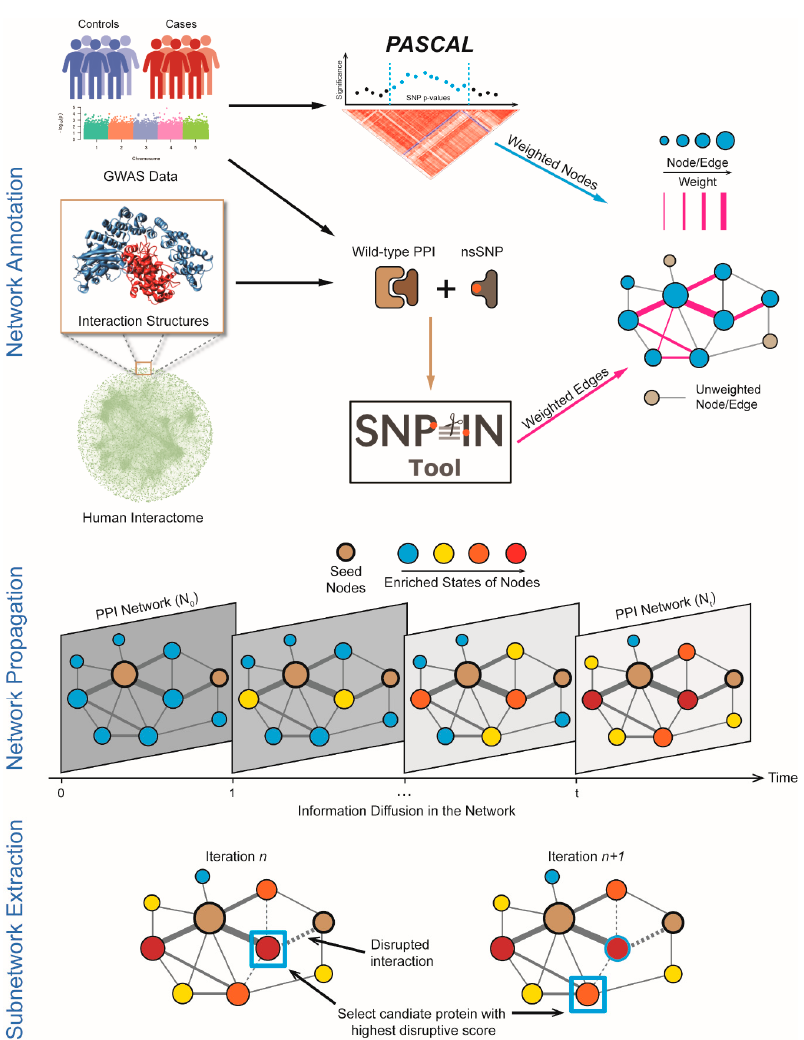
Figure 1. Basic workflow of Discovering most IMpacted SUbnetworks in interactoMe